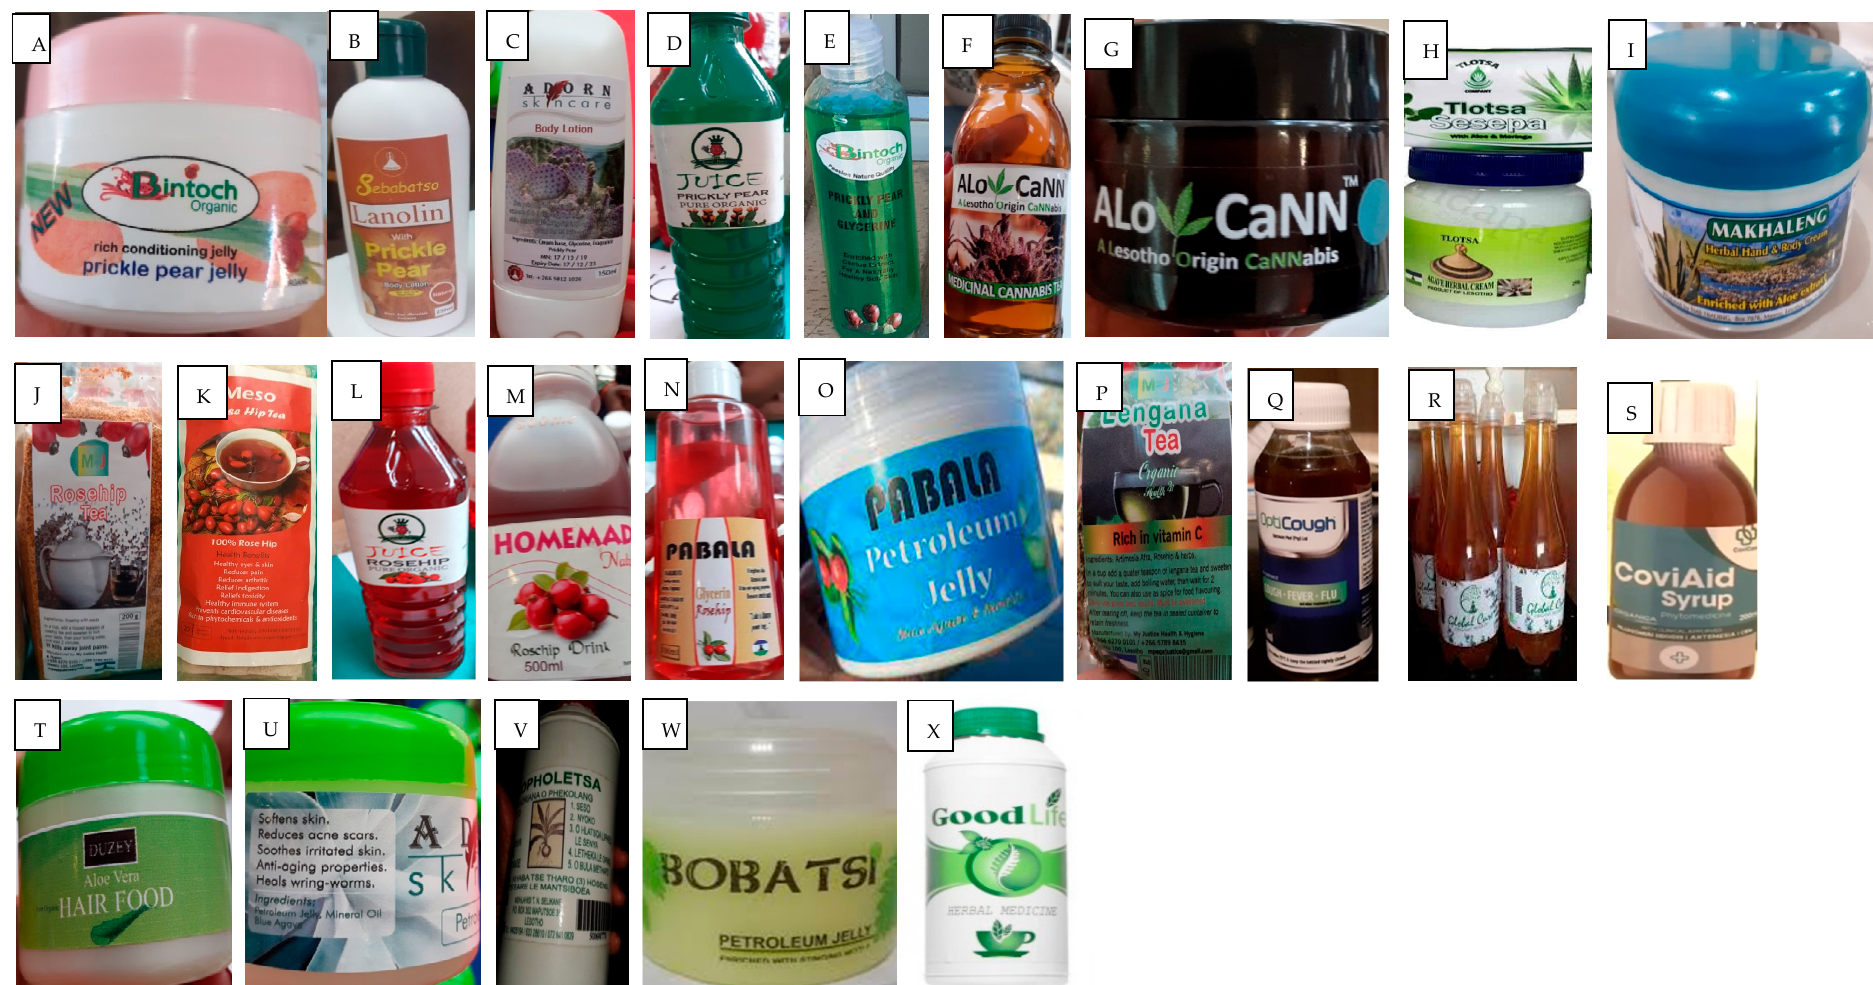
Figure 3. Some of the commerical products developed in Lesotho using different plants: ( A – E ) Opuntia ficus-indica , ( F , G ) Cannabis sativa , ( H , I ) Agave americana , ( J – O ) Rosa rubiginosa , ( P – S ) Artemisia afra , ( T , U ) Aloe ferox , ( V ) Ledebouria cooperi , ( W ) Urtica urens , ( X ) Hypoxis hemerocallidea . Source: L. Seleteng-Kose & P. Likoetla.